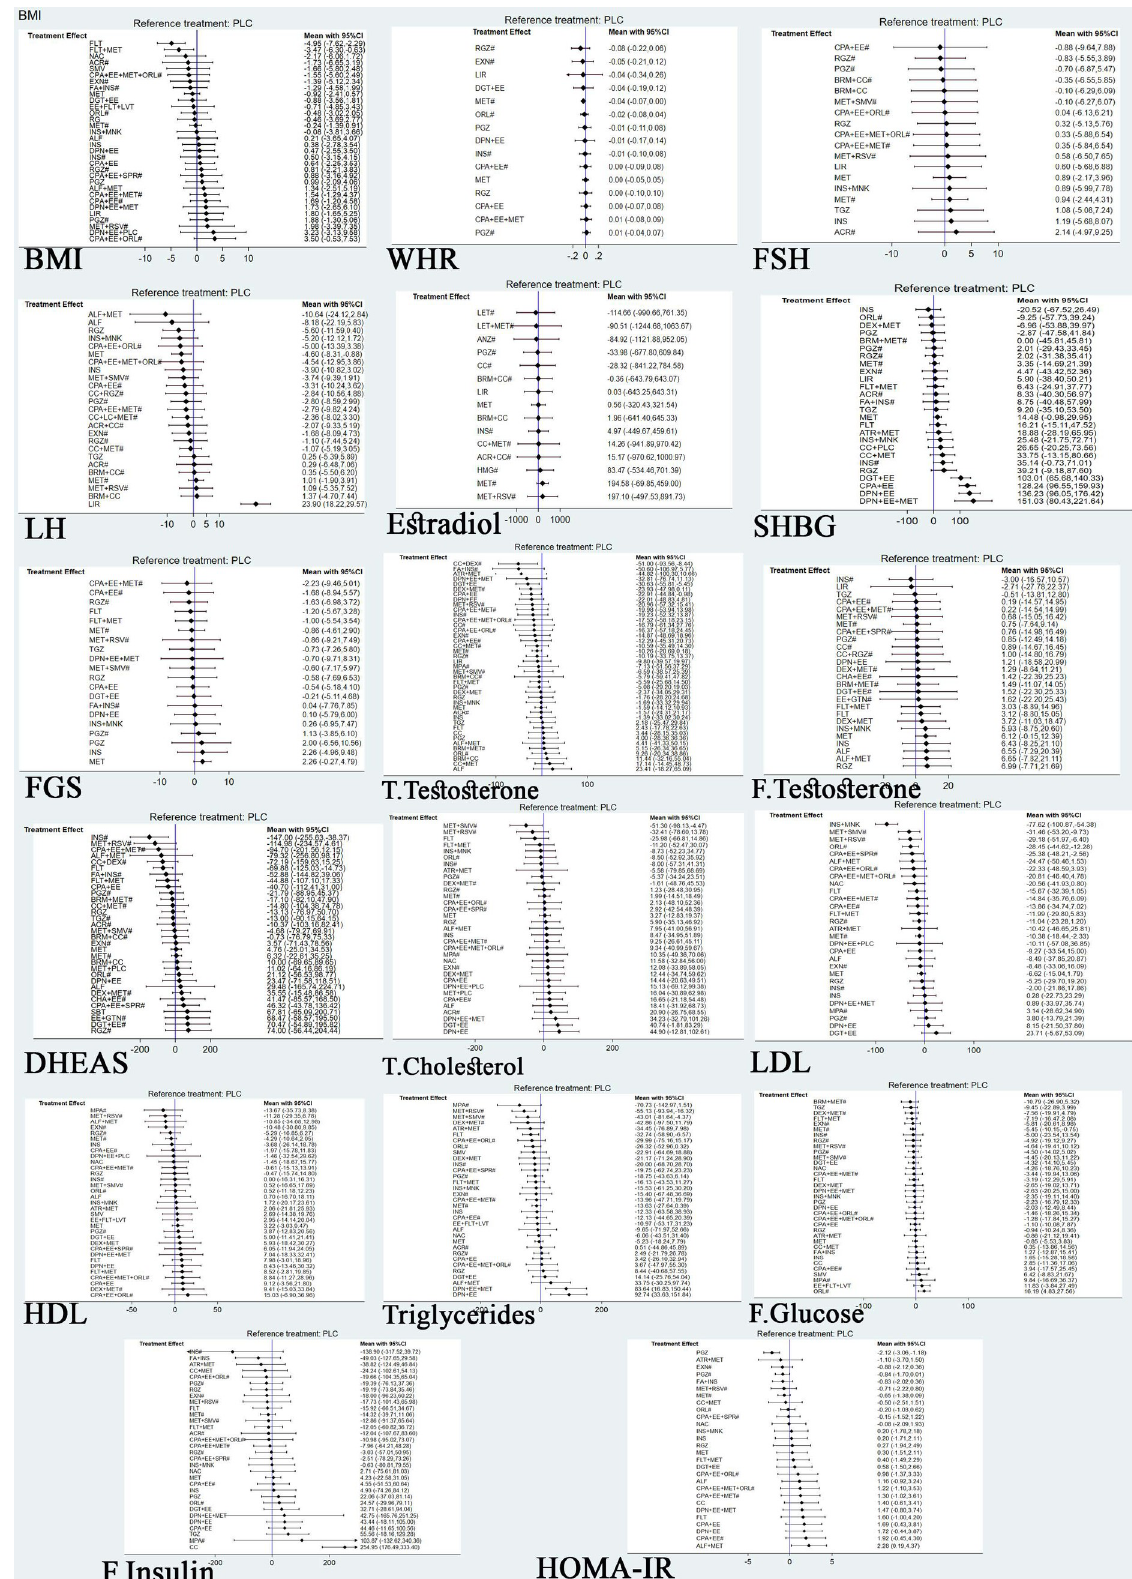
Fig 3. Forest plots show the mean difference (MD) of different interventions compared with placebo for each outcome, along with the associated 95% CI. Interventions: acarbose (ACR), alfacalcidol (ALF), anastrozole (ANZ), clomiphene citrate (CC), exenatide (EXN), folic